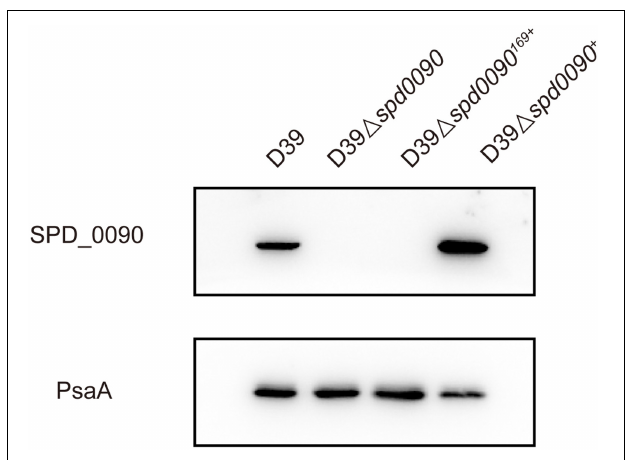
FIGURE 2 | The construction and verification of the D39 (cid:49) spd0090 , D39 (cid:49) spd0090 169 + , and D39 (cid:49) spd0090 + strains. Whole-cell proteins isolated from D39, D39 (cid:49) spd0090 , D39 (cid:49) spd0090 169 + , and D39 (cid:49) spd0090 + were extracted to perform Western blot to validate gene knockout and complement strains. PsaA was used as loading controls.